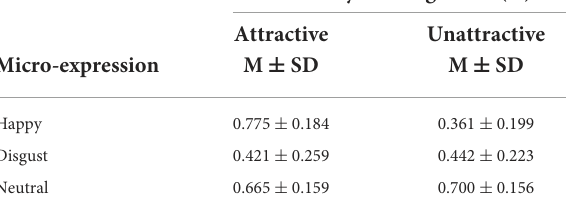
TABLE 1 Mean accuracy of recognition of each Micro-expression in Experience